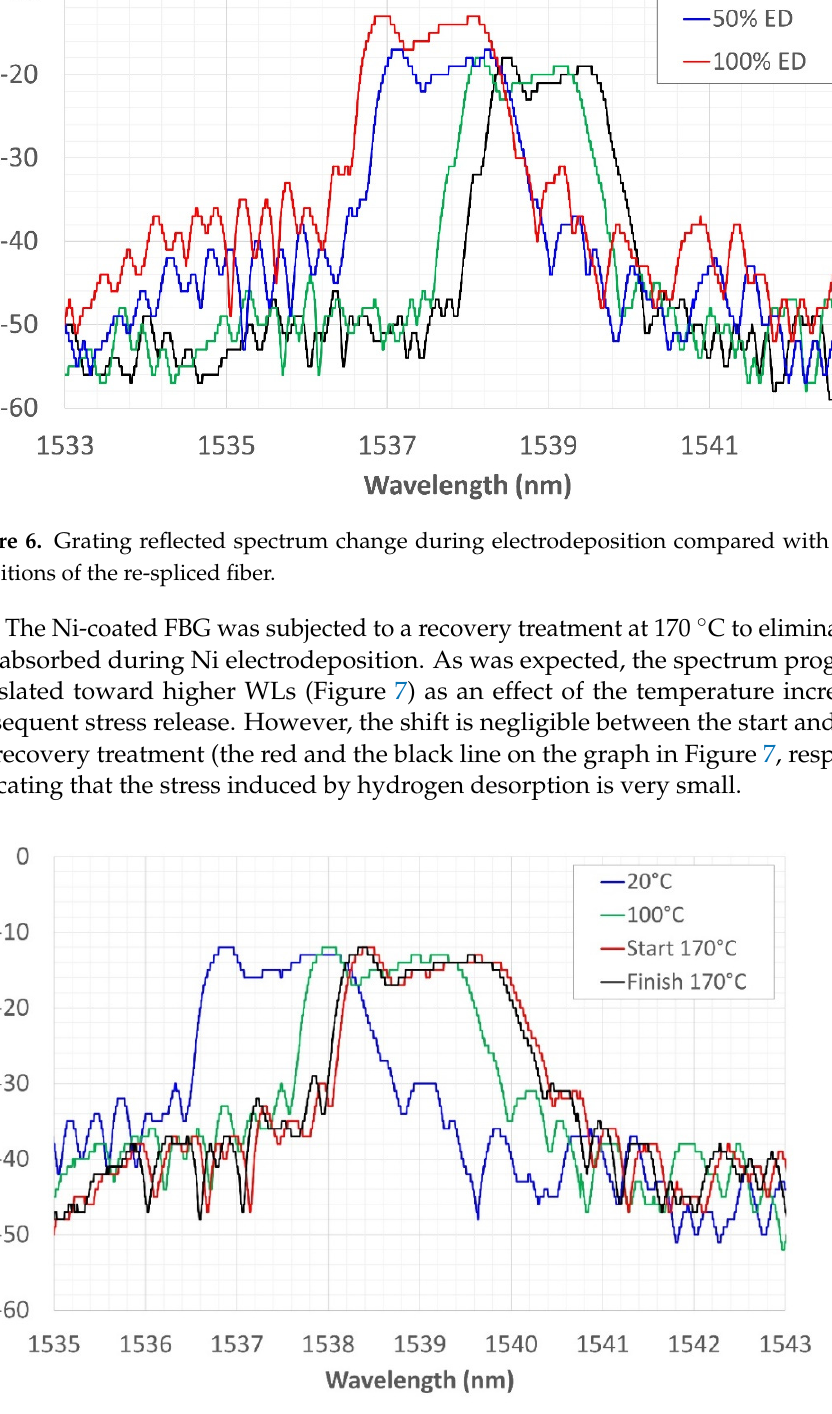
Figure 7. Grating reflected spectrum change during the recovery at 170 °C.